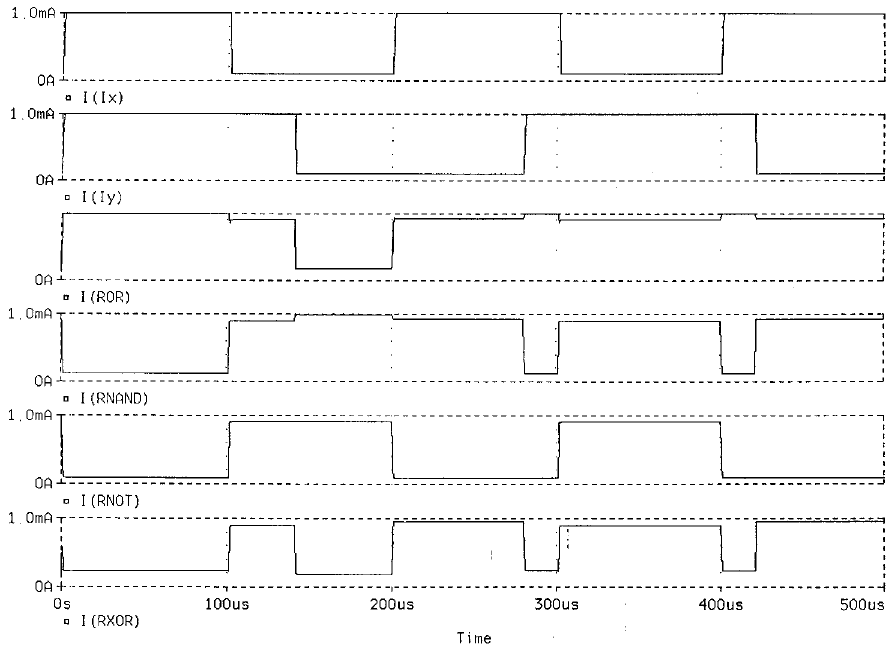
FIGURE 2 Results obtained from the proposed circuit of Fig. 1 with DC supply voltage